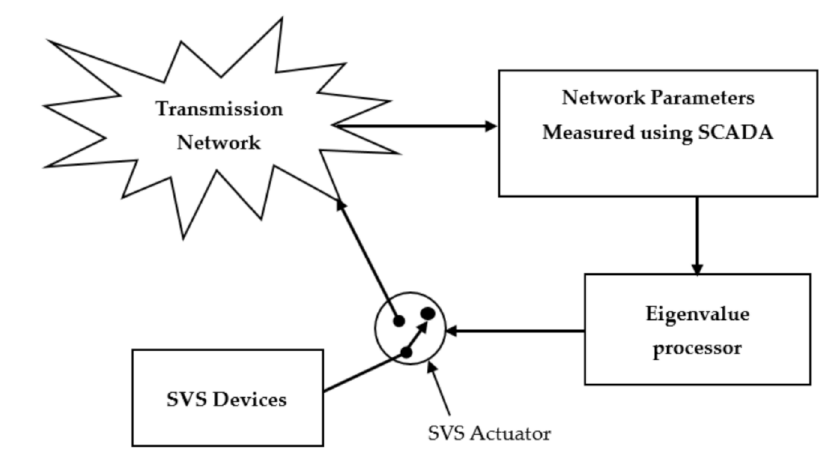
Figure 5. A flow chart of transmission network transient analysis and automated compensation.